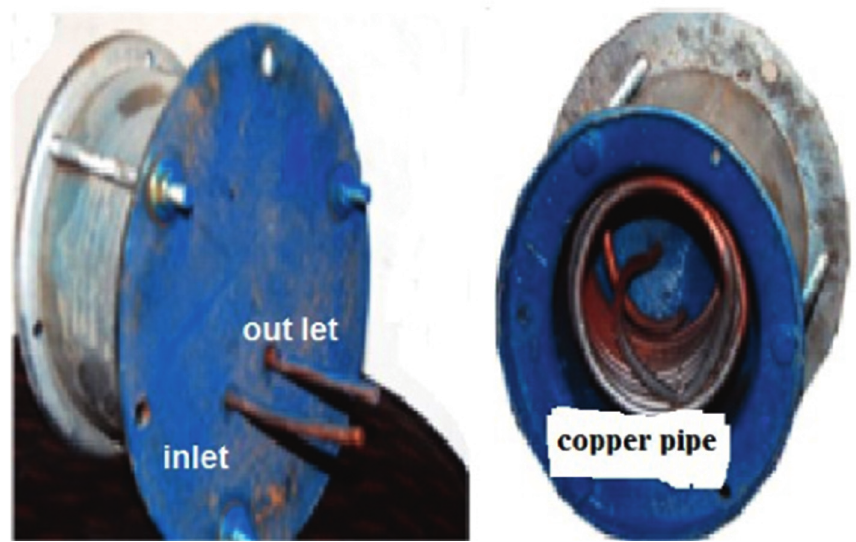
Figure 3: The receiver, from rear and front.